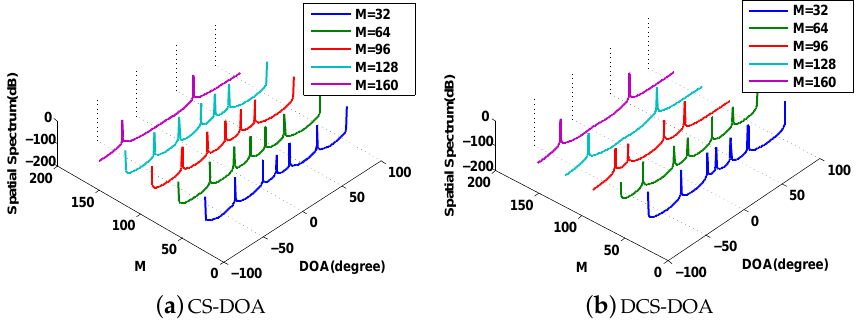
Figure 10. The comparison of DOA spatial spectrum between CS-DOA and DCS-DOA with packet size =